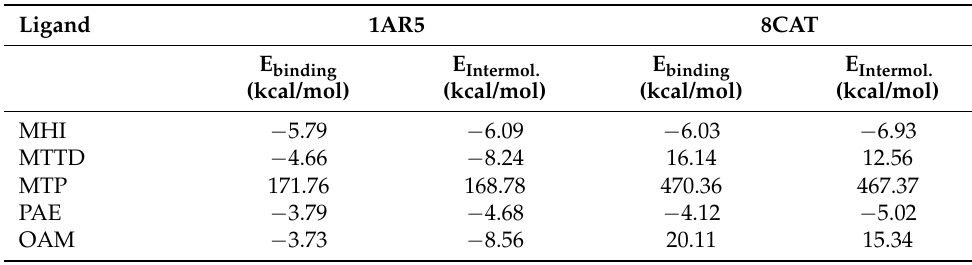
Table 2. Energy parameter values from the molecular docking of the studied ligands against the oxidant activity of 1AR5 and